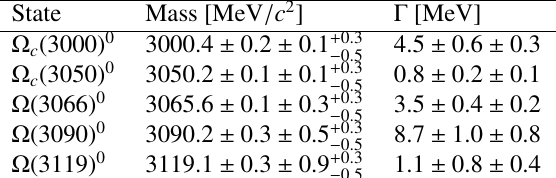
+ K − ) for all candidates passing the likelihood Figure 4. Distribution of the reconstructed invariant mass m ( Ξ 0 c ratio selection; the solid (red) curve shows the result of the fit, and the dashed (blue) line indicates the fitted background. The shaded (red) histogram shows the corresponding mass spectrum from the Ξ + sidebands and c the shaded (light gray) distributions indicate the feed-down from partially reconstructed Ω c ( X ) 0 resonances. This figure is taken from Ref. [25]. Table 2. Properties of the excited Ω 0 c